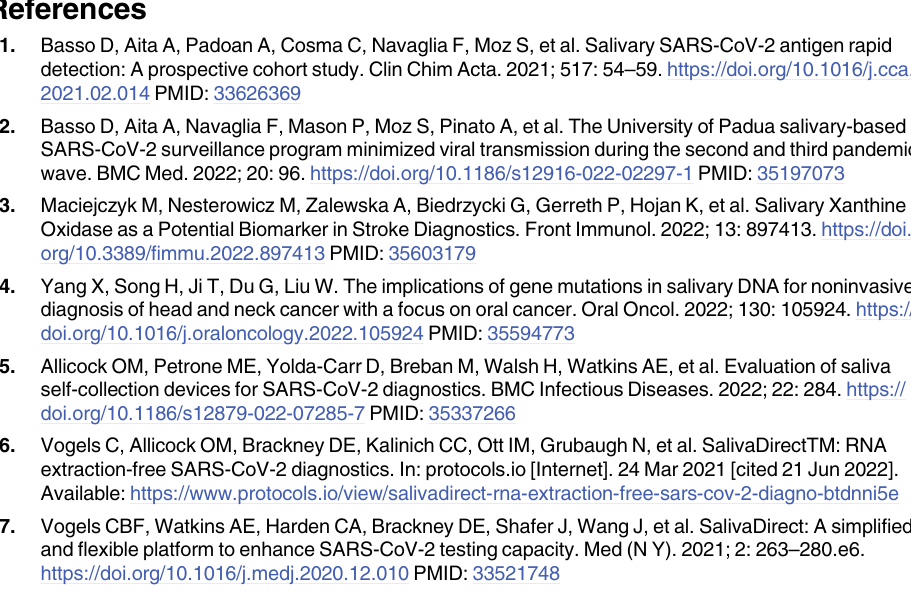
S1 Table. Test and re-test Ct value differences by month from samples with complete data. S2 Table. Test and re-test antigen concentration differences by month excluding observa- tions that were below the limit of